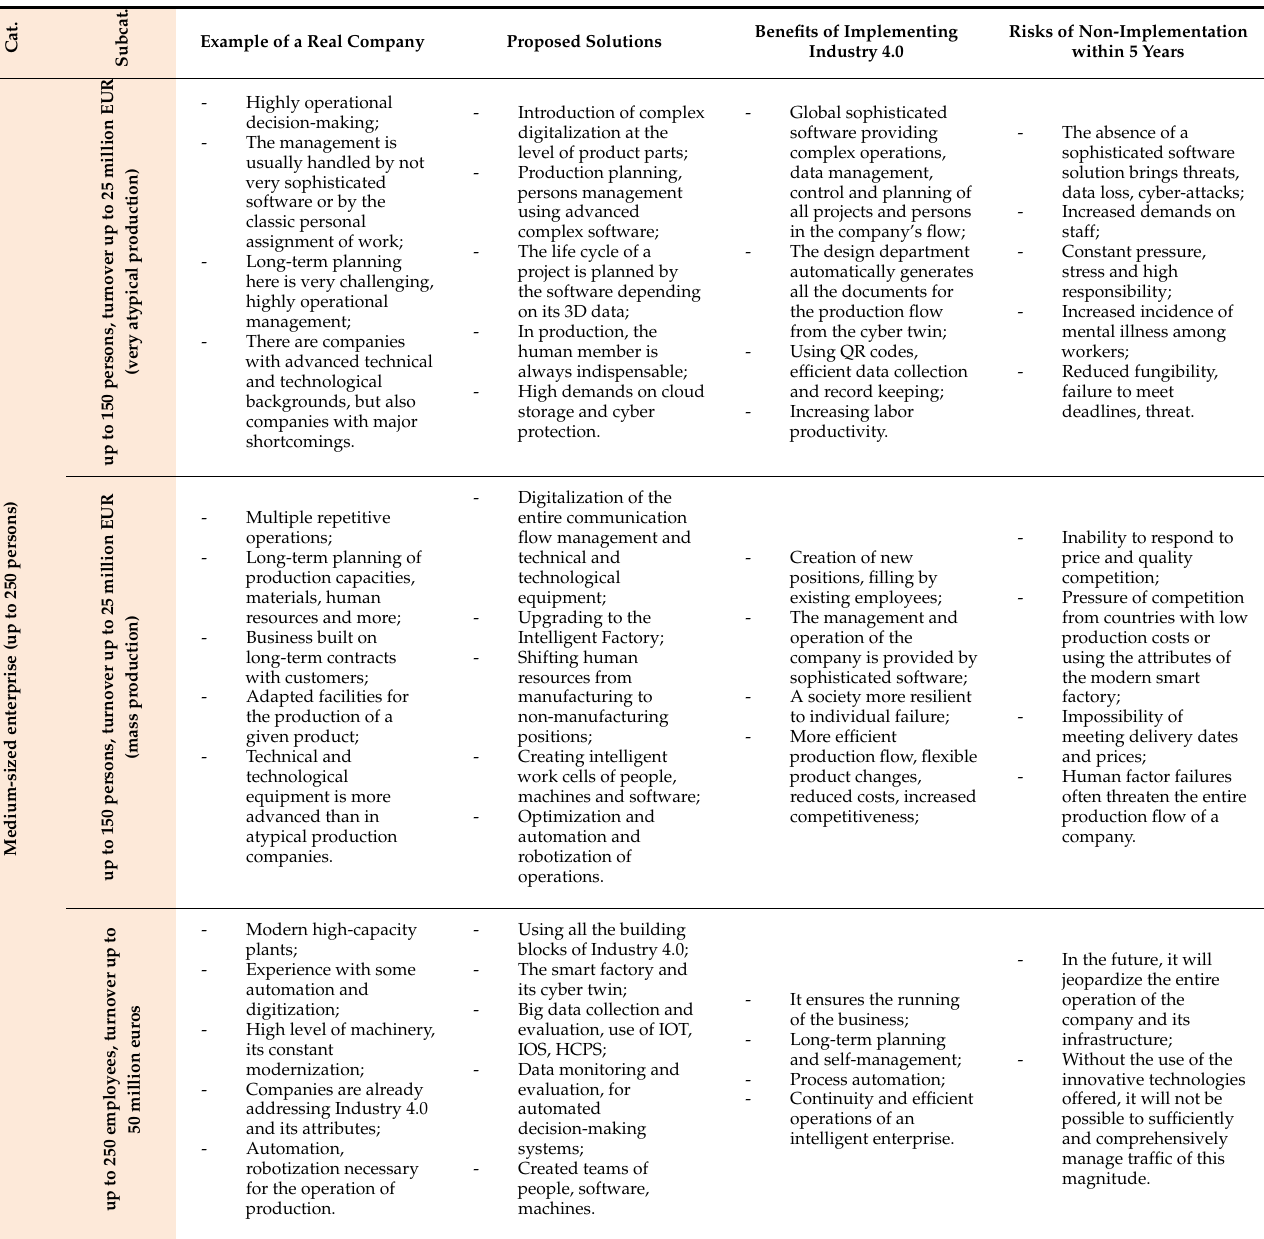
Table 6. Main results and recommendations (scored) for medium-sized enterprises and their subcate- gories ( n =